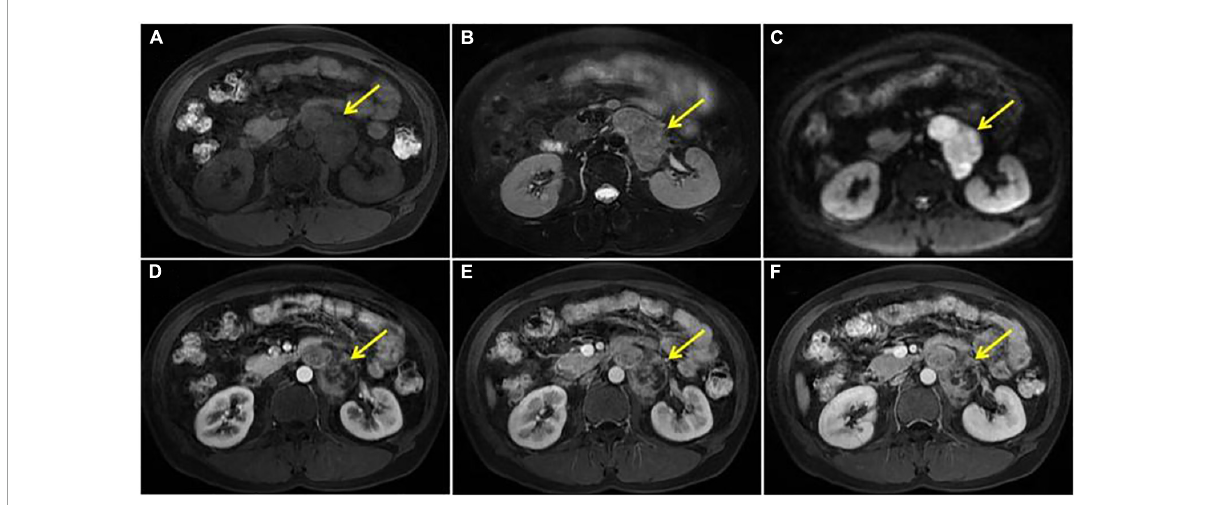
FIGURE1 Magnetic resonance imaging (MRI) findings. Low signal on T1WI and heterogeneously high signal on T2WI [ (A,B) , arrows], and high signal on axial diffusion-weighted imaging [DWI, B600; (C) , arrow] indicate the presence of a retroperitoneal mass. Axial early arterial and portal venous post-contrast T1-weighted fat-suppressed imaging findings indicating a heterogeneously enhanced mass are shown [ (D,E) , arrows]; Retroperitoneal mass enhancement is more obvious in the delayed post-contrast T1-weighted fat-suppressed image [ (F) , arrow].